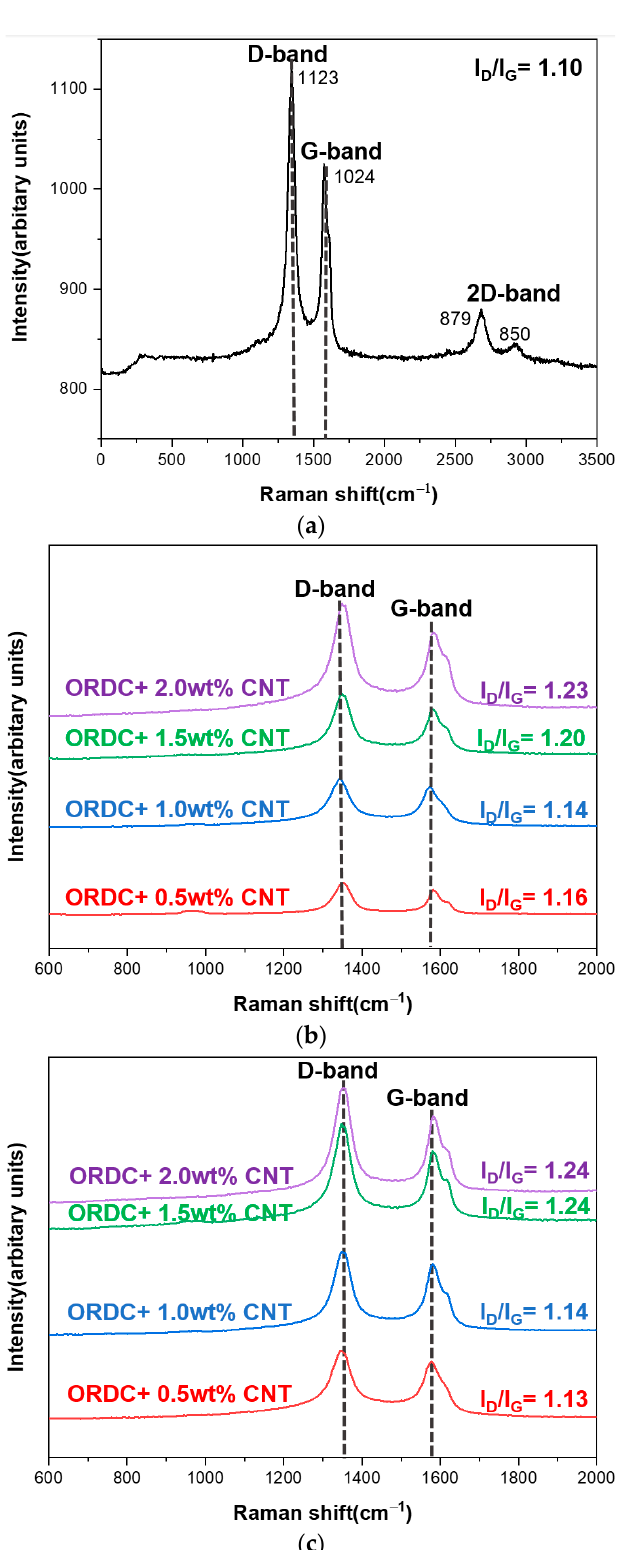
Figure 9. Raman spectroscopy analysis of ( a ) as-received CNTs and 0.5–2.0 wt% CNT-added composites cast using a ( b ) single gate and ( c ) poly gate by using ORDC. The as-received CNT powder (Figure 9a) showed D and G peaks with values of 1123 and 1024 at ~1344 cm − 1 and ~1573 cm − 1 , respectively, indicating that ID/IG = 1.10. The 0.5